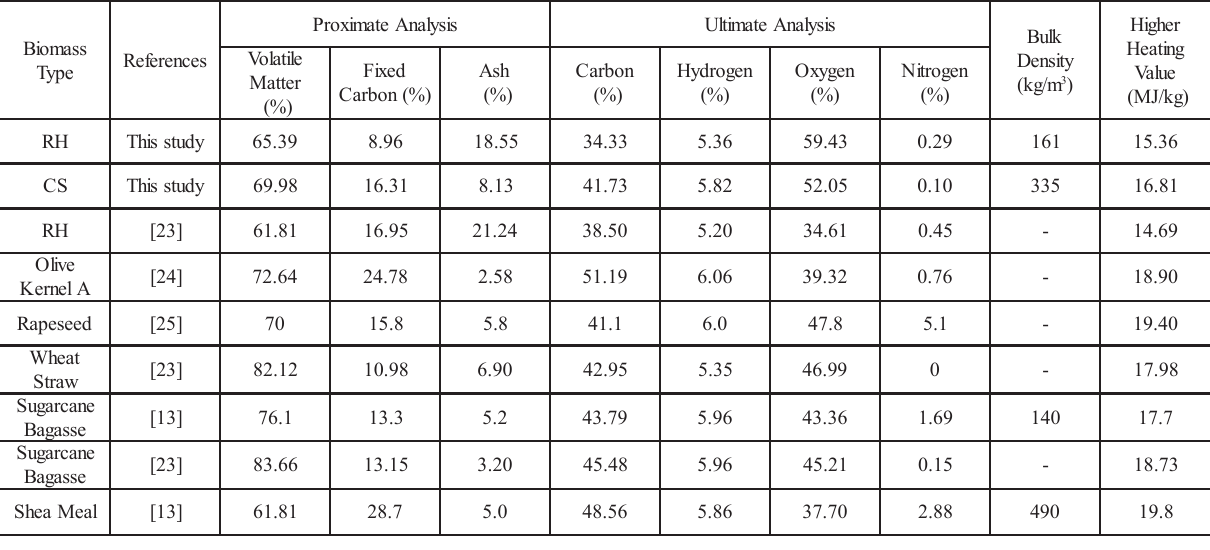
TABLE 1. THE ULTIMATE AND PROXIMATE ANALYSIS OF RH AND